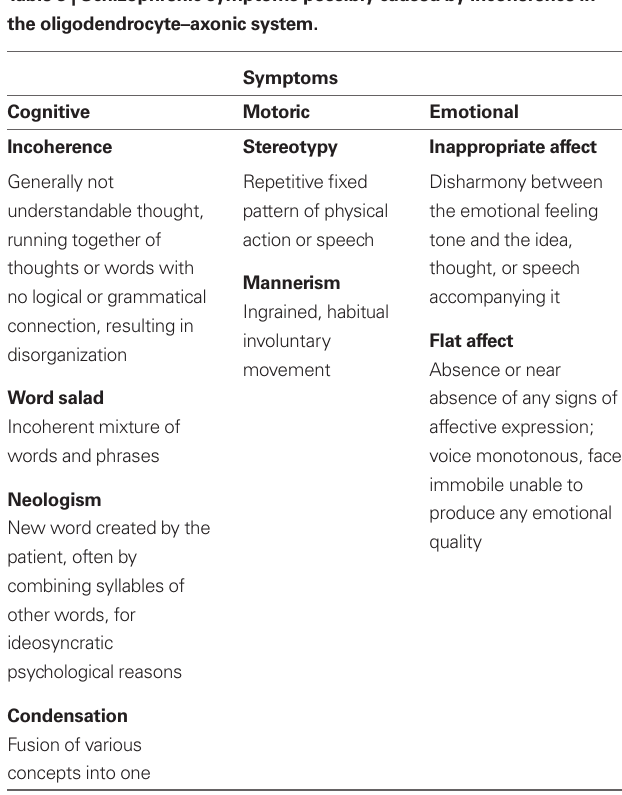
interconnected via gap junctions (g.j.) is outlined ( Figure 4 ). A loss of Oc may cause a decay of Oc-Ac gap junctions (crosses). Such a “leaky” panglial syncytium may be responsible for memory